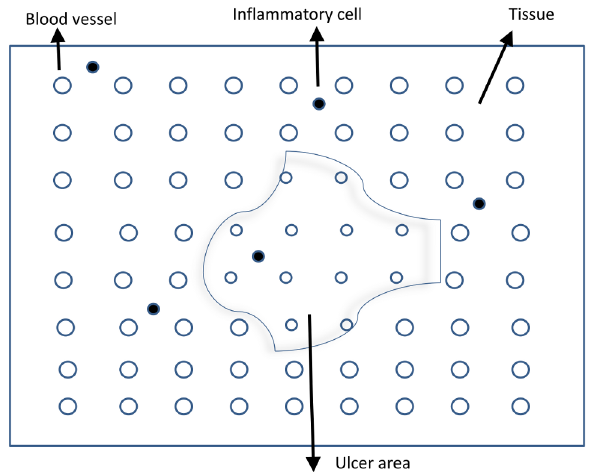
Figure 1. Hybrid model of pressure ulcer formation. The model representation of the pressure ulcer formation process is shown.